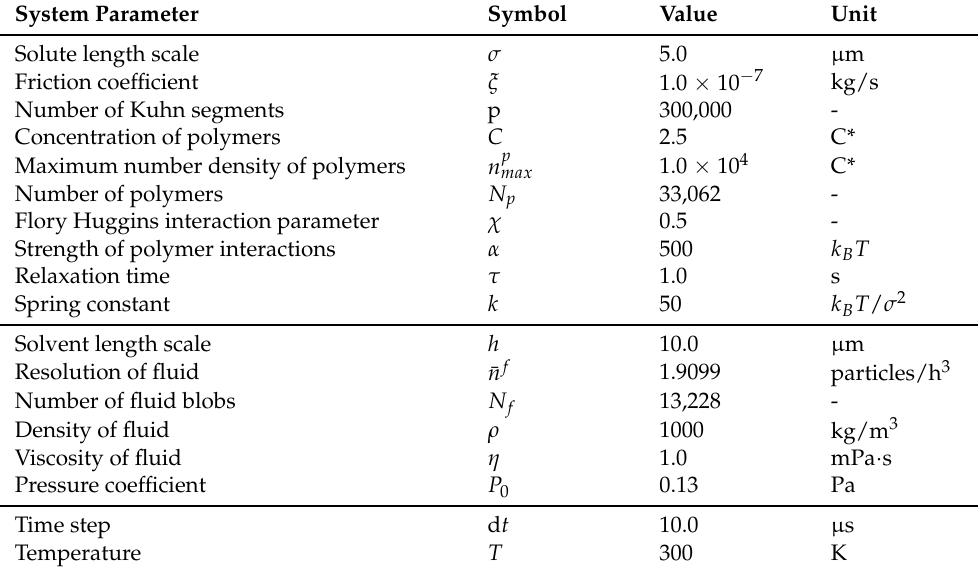
Table 1. Summary of system